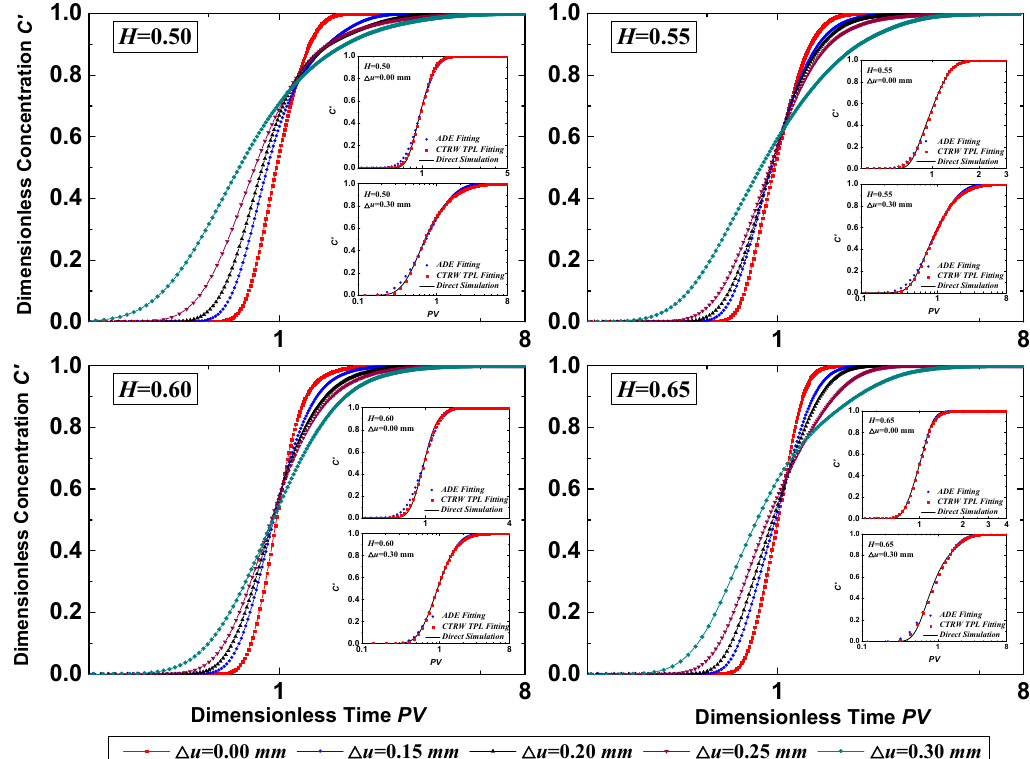
Figure 14. Variations of BTCs at the outlets for fractures with different Δ u and H . The inserted figures show the best-fitted BTCs using the advection–dispersion equation (ADE) and continuous time random walk–truncated power law (CTRW–TPL) models.